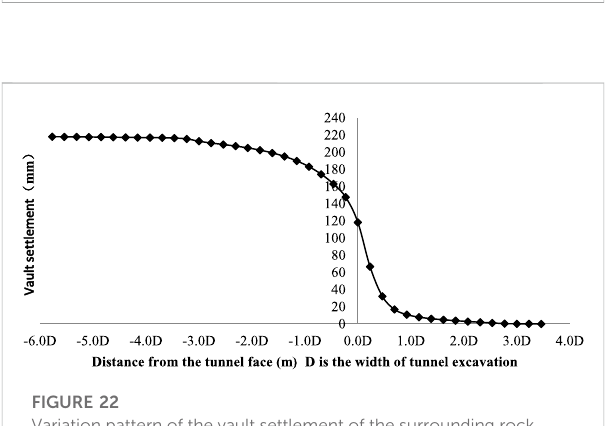
FIGURE 19 Variation of the deformation of tunnel surrounding rock with burial depth.